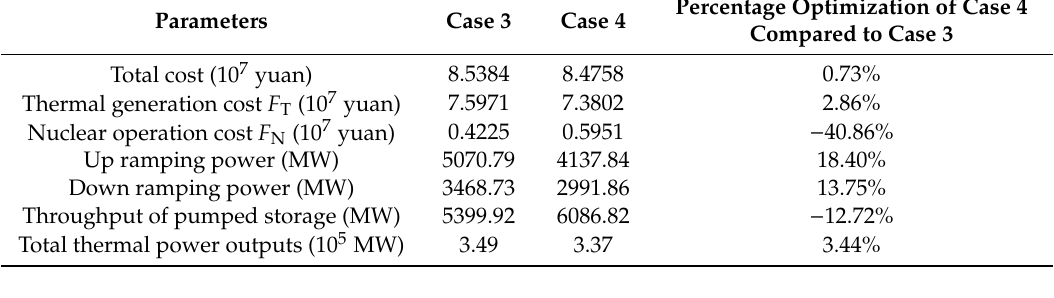
Table 3. Result comparison of Case 3 and Case 4 in a day.